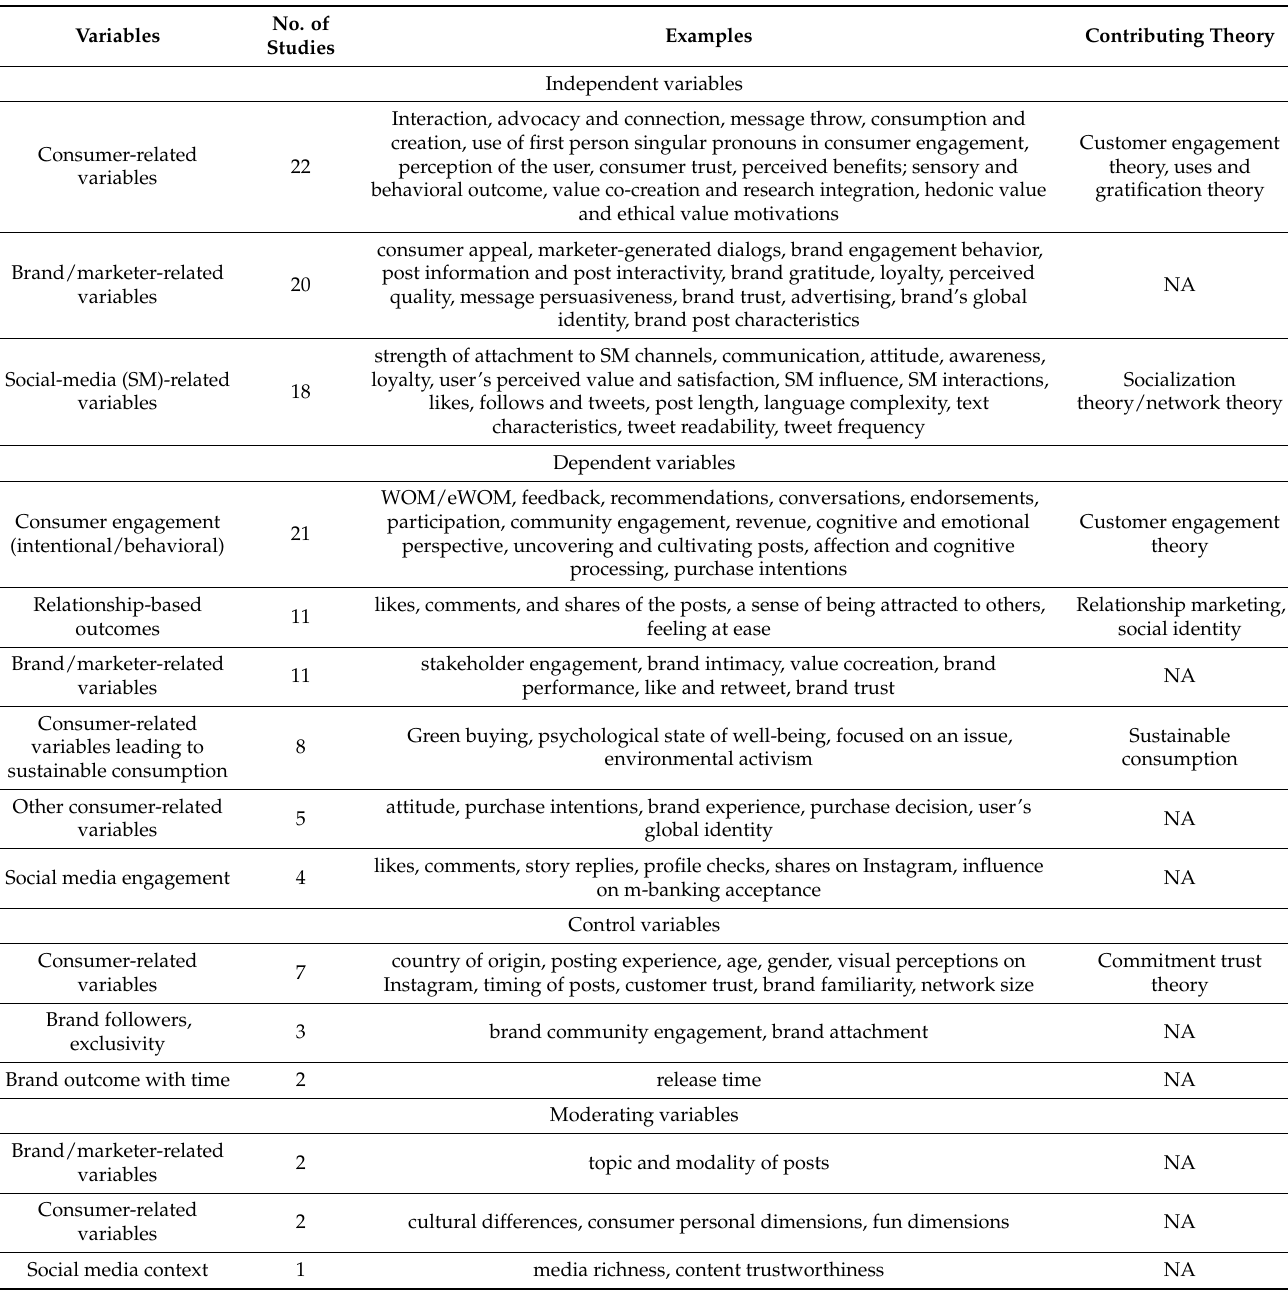
Table 5. Variables investigated in social media consumer engagement research in the context of sustainable